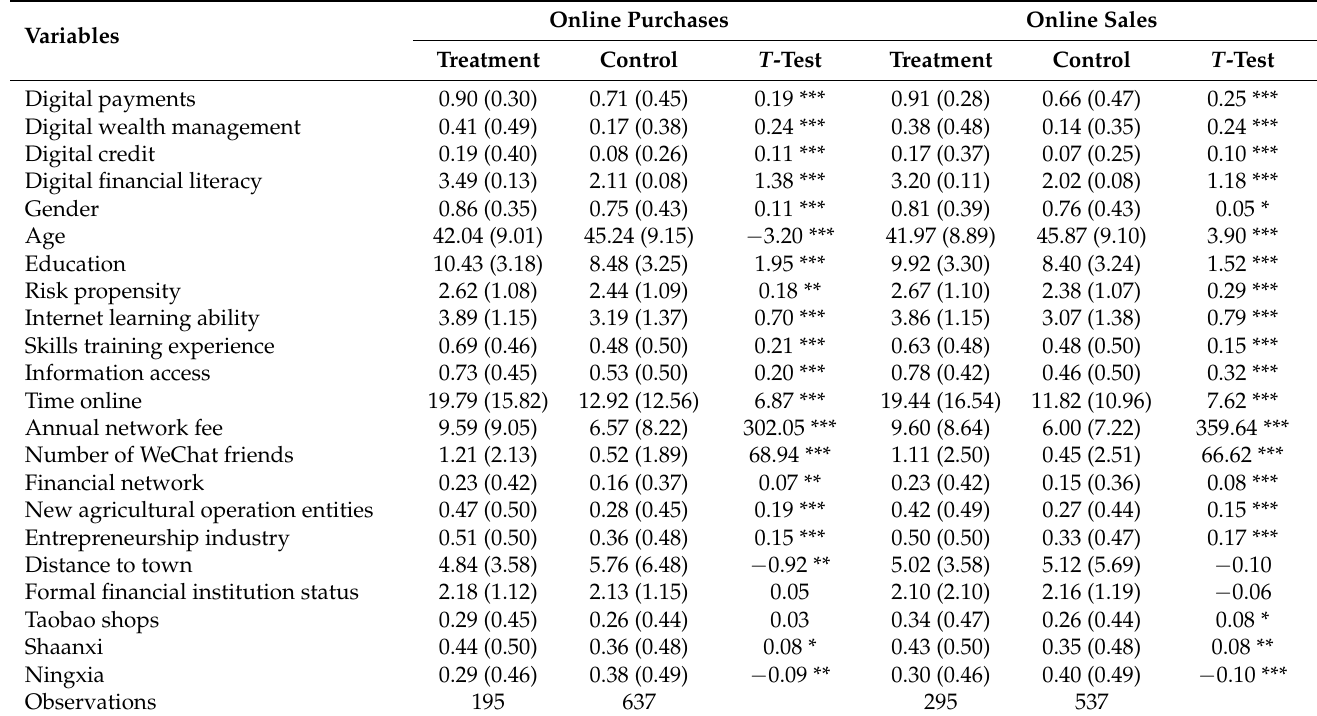
Table A1. Definition and summary of